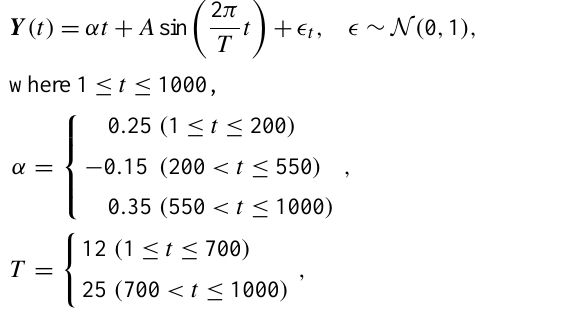
Fig. 6. Logarithmic singular value spectra expressed on percentage (a) for L SSA = 100 and (b) for the first 8 modes.